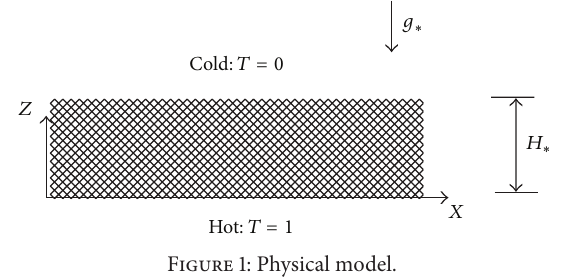
Figure 1: Physical